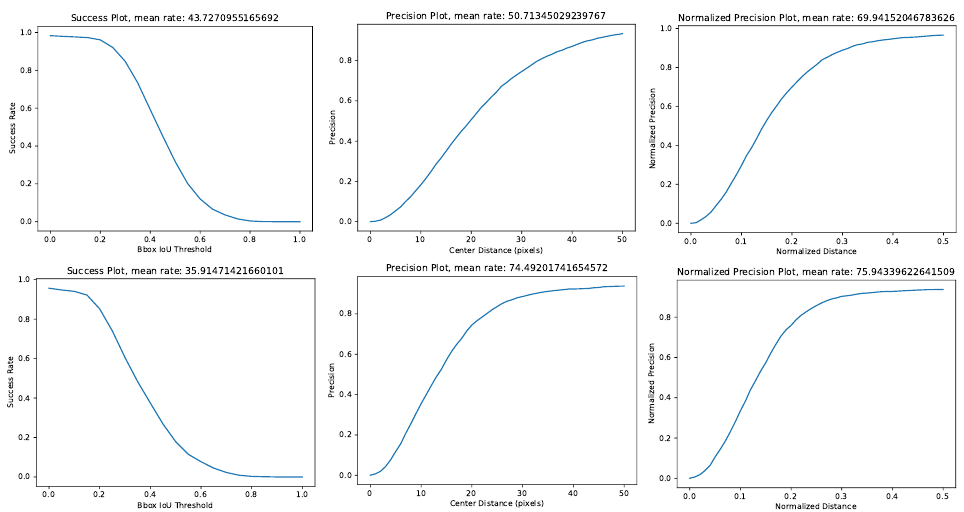
Figure 9. Quantitative results of dog tracking in two videos. The widely used success rate, precision and normalized precision are used in evaluation.